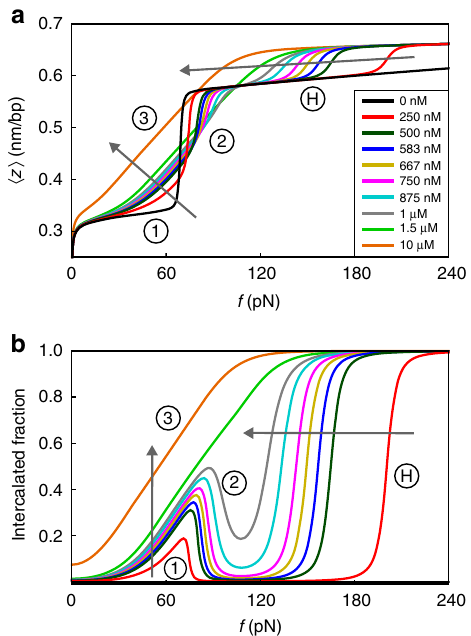
Fig. 2 Theoretical curves of the DNA extension per base pair ( a ) and fraction of intercalator-bound base pairs ( b ) as a function of the applied force for intercalator concentrations C that match the experimental ones of Fig. 1. The arrows indicate the direction of increasing concentration. The model parameters, obtained from a fi tting procedure, are discussed in Supplementary Note 1. The features 1, 2 and 3 and the prediction H are discussed in the main